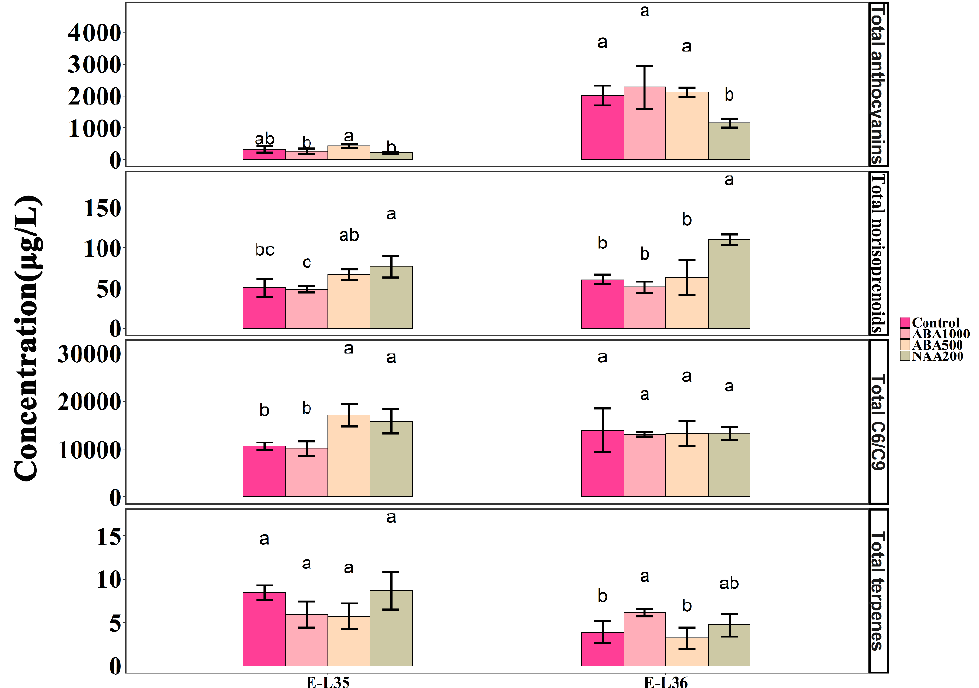
Figure 8. Changes in the concentrations of total anthocyanins, total norisoprenoids, total C6 / C9 compounds, and total terpenes in the different treatments. Different letters indicate significant differences ( p = 0.05).